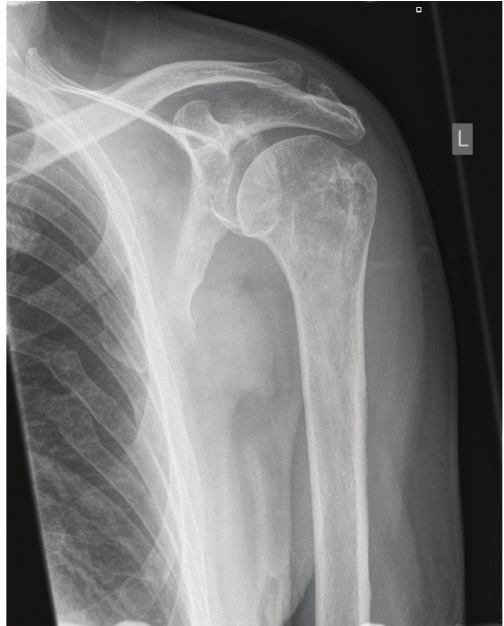
Figure 1: X ray left shoulder.